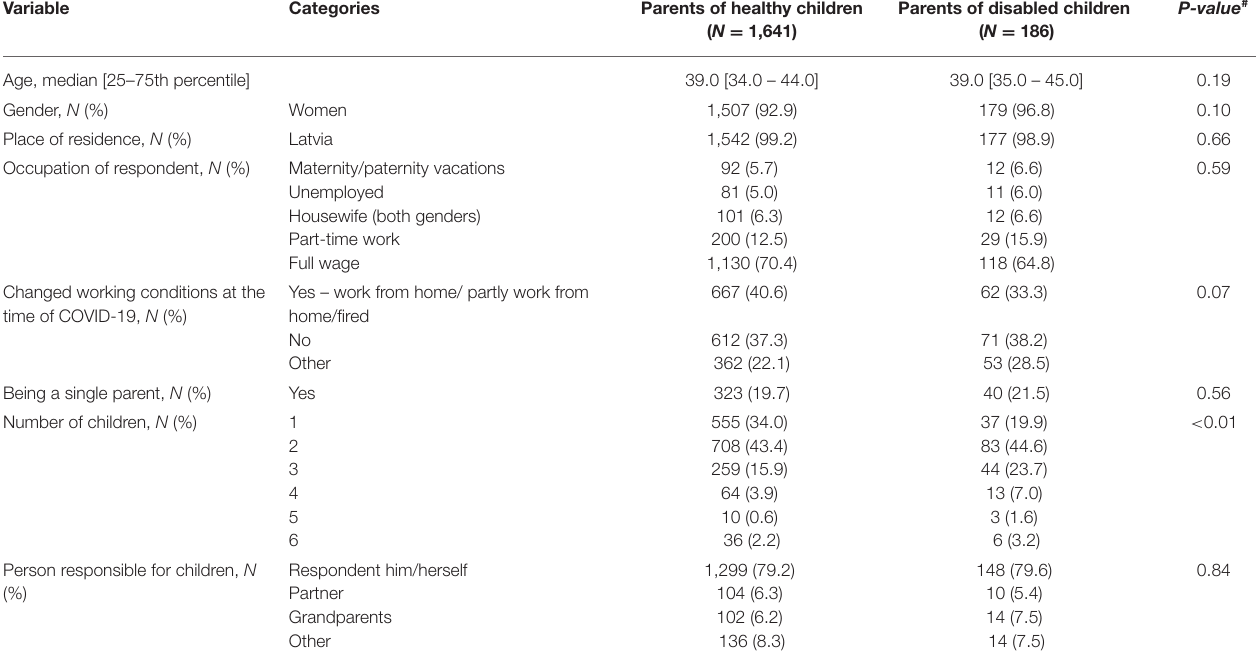
TABLE 1 | Descriptive statistics of study population of Latvian participants, by group.